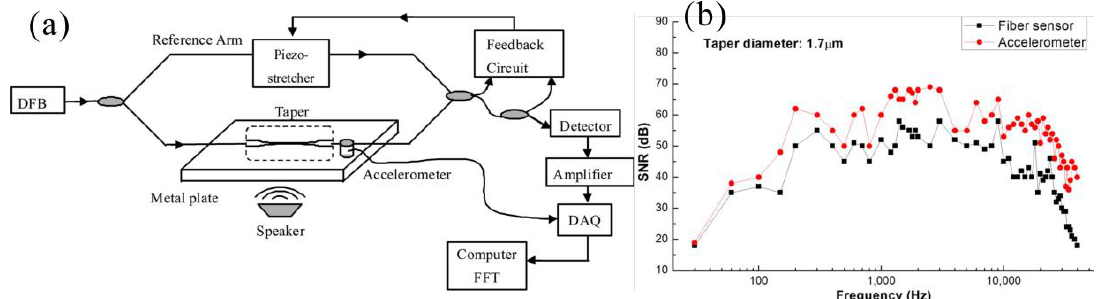
Figure 6. ( a ) Schematic of experimental setup; ( b ) Frequency responses of the taper sensor and piezoelectric accelerometer [103].